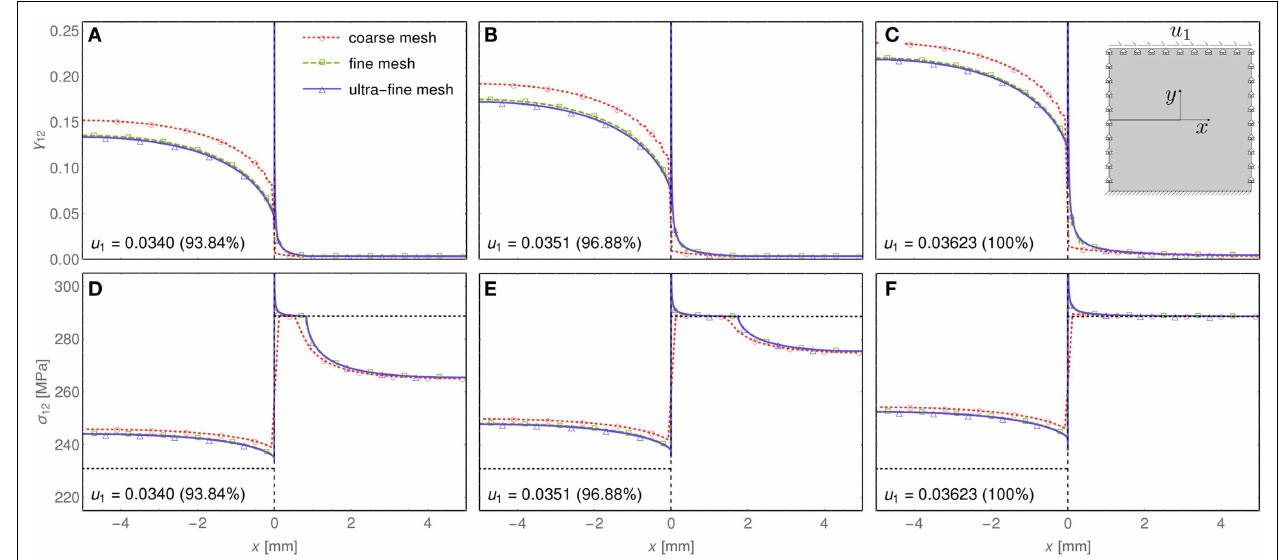
inside the pre-existing shear band than that in the outer domain.Three different stages of deformation are shown, corresponding to a prescribed displacement at the upper edge of the square domain u 1 = 0.0340mm (left),